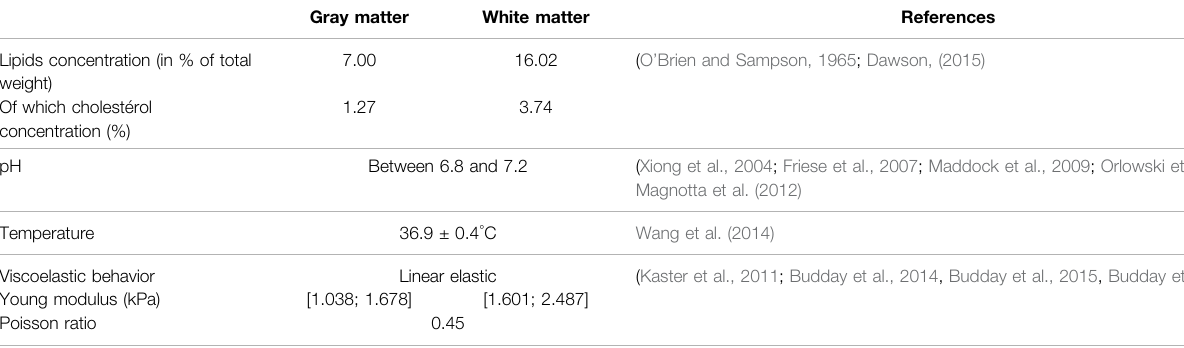
TABLE 1 | Macroscopic chemical and physical properties of the human